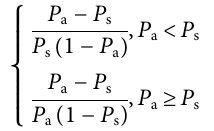
Frontiers in Earth Science |